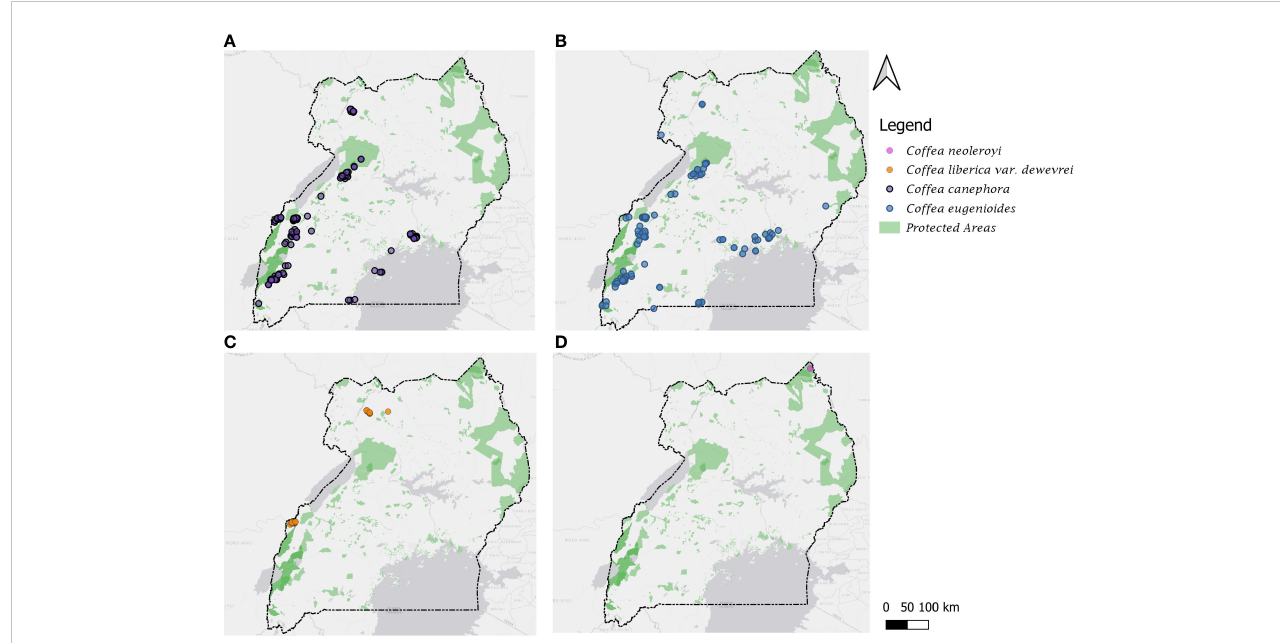
FIGURE 1 Distribution maps for the four indigenous Coffea species of Uganda. (A) C. canephora ; (B) C. eugenioides ; (C) C. liberica var. dewevrei ; (D) C. neoleroyi . Protected areas based on World Database on Protected Areas (see